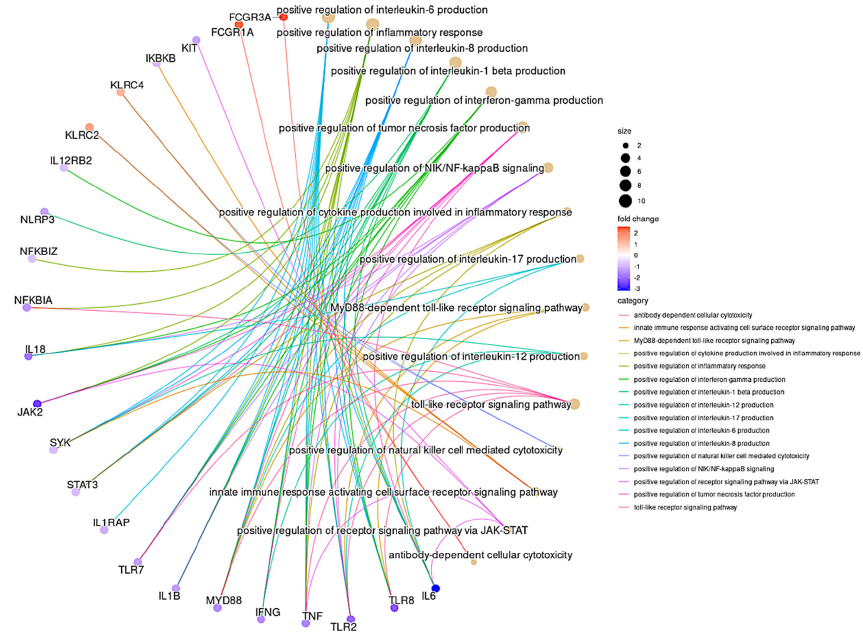
Figure 4. Gene Ontology pathway network analysis of DEGs. GO pathway network analysis of the top 16 enriched GO terms in the differentially expressed genes for ADCC and innate immune inflammatory pathway (Fisher’s exact test using enrichGO function in R package clusterProfiler, multiple test correction by Benjamini–Hochberg method, adj. p -value < 0.05). The colour gradient scale indicates the log2FC of genes.